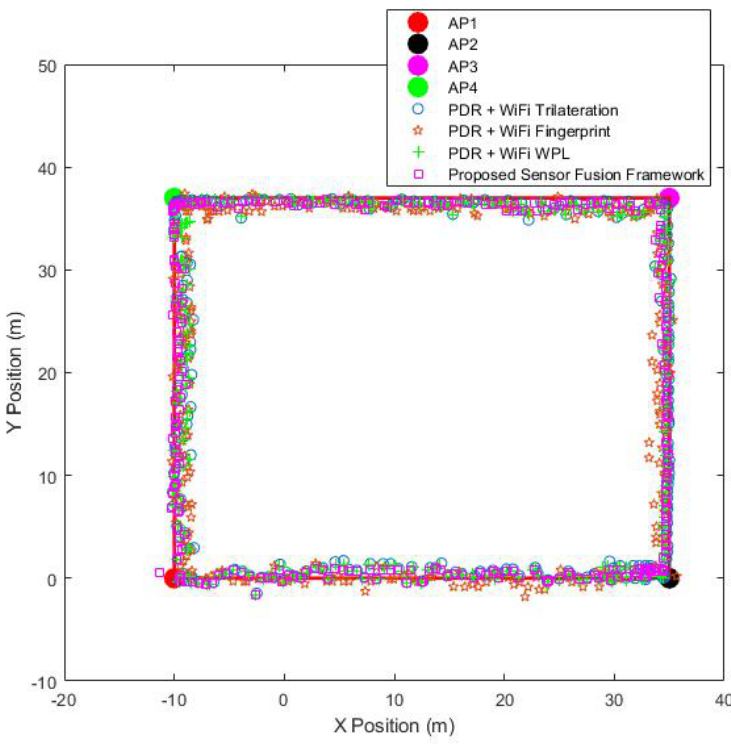
Figure 7. Trajectories of ground truth, proposed sensor fusion framework, conventional sensor fusion frameworks from rectangular motion.